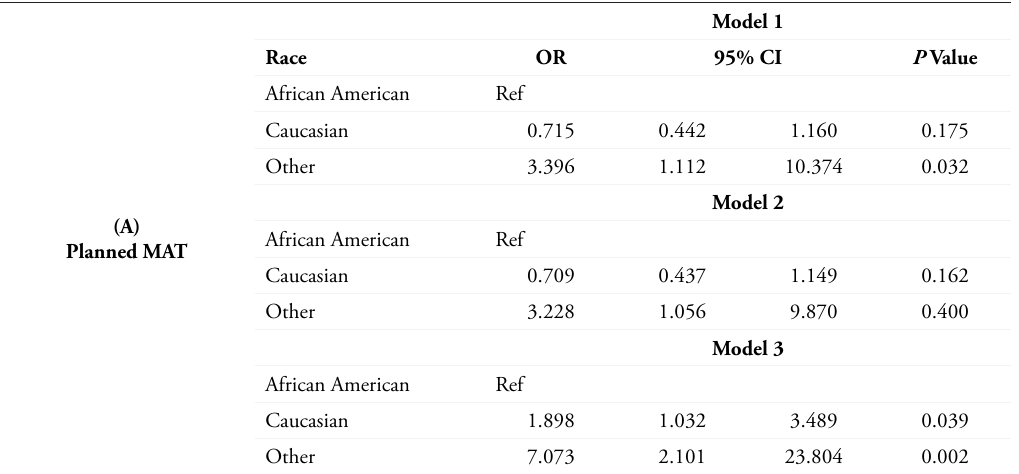
Table 6. Regression Results in Cincinnati CBSA by Race: (A) Planned Medication-Assisted Opioid Therapy (MAT), (B) Number of Days Waiting to Enter Treatment